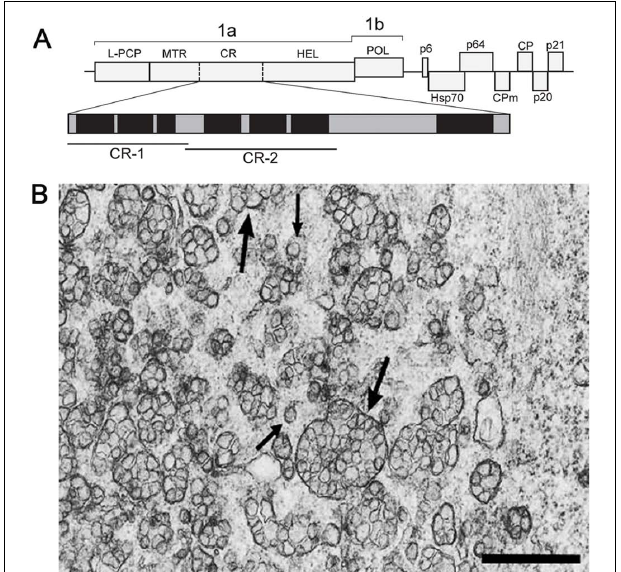
FIGURE 1 | (A) Schematic representation of the BYV genome and the encoded proteins. 1a polyprotein encompasses the leader papain-like cysteine proteinase (L-PCP), methyltransferase (MTR), unique central region (CR), and NTPase/helicase (HEL).Vertical solid bar, established cleavage site of the L-PCP; broken bars, arbitrary cleavage sites within the 1a polyprotein calculated from the apparent molecular masses of the MTR- and HEL-containing proteins. Enlarged map of hydrophobic domains (black) and hydrophilic hinges (gray) in the 1a CR is shown below.The portions used for cloning and expression as GFP C-terminal fusions (CR-1 and CR-2) are indicated by bars. (B) Electron microscopy of the BYV-induced ultrastructures in leaf parenchyma cells of Tetragonia expansa (21 days p.i.). Double-membrane vesiles (DMVs, small arrows) and vesicle packets (VPs, large arrows) on a tissue section embedded in Epon after fixation with glutaraldehyde and OsO 4 . Scale bar, 1 μ